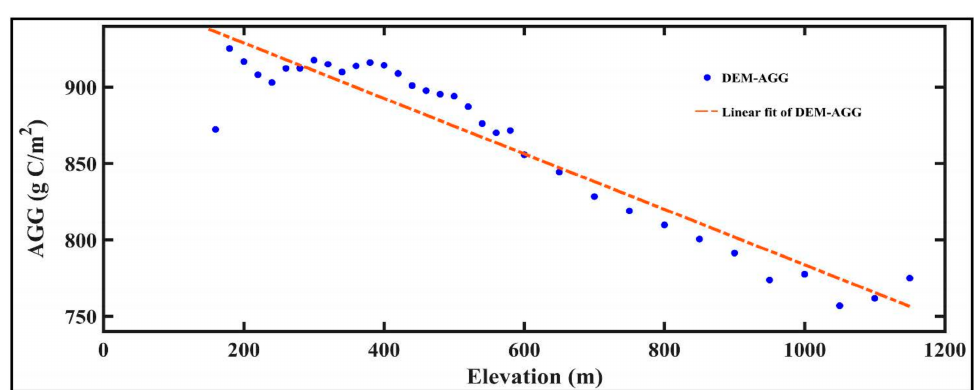
Figure 12. Variation of AGG with